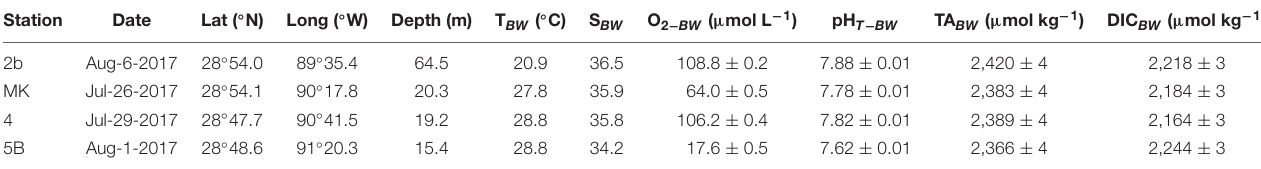
TABLE 1 | Position, depth, and sampling date of the four stations on the Louisiana shelf (nGoM) along with parameters recorded in the bottom waters (T, S, O 2 , pH, TA, and DIC). Station